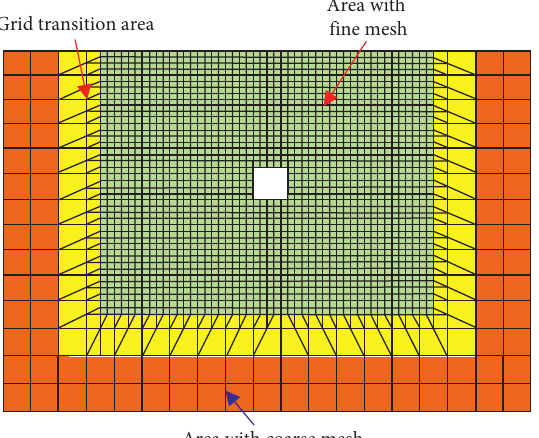
Figure 4: Grid transition area